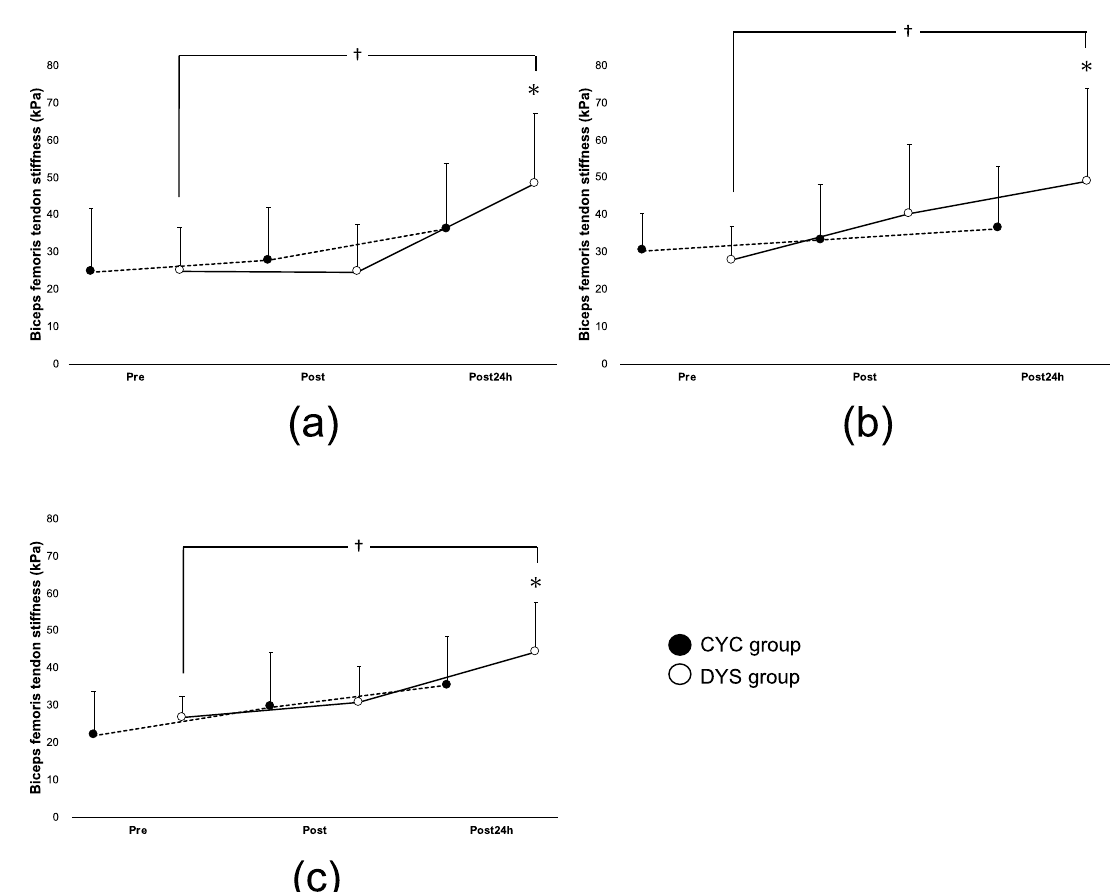
Figure 3 . Variance of biceps femoris tendon stiffness readings in EX condition. ( a ) Biceps tendon stiffness from pre-exercise to Post 24 h in Week 1, ( b ) biceps tendon stiffness from pre-exercise to Post 24 h in Week 2, ( c ) biceps tendon stiffness from pre-exercise to Post 24 h in Week 3. The CYC group is represented by black circle markers and the DYS group by white circle markers. Error bars represent SD. * indicates p < 0.05 between CYC and DYS group in time point. † indicates p < 0.05 compared to Pre and Post 24 h in DYS group.